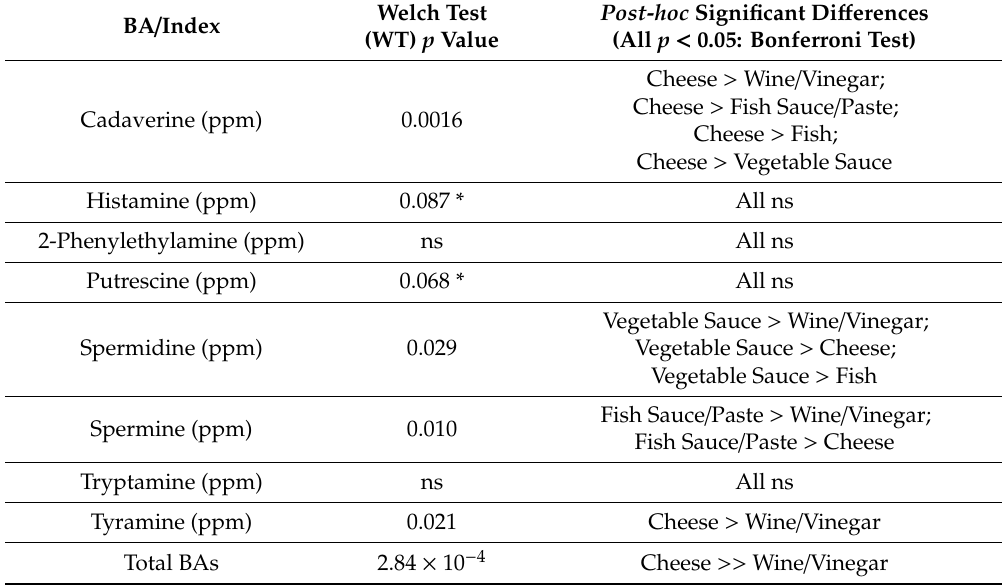
Table 3. Statistical significance and nature of di ff erences between the mean BA contents and other food quality indices for fermented food products. Both robust Welch and Bonferroni-corrected post - hoc ANOVA test significance ( p ) values are provided. Abbreviations: ns, not statistically significant. * These values were close to statistical significance, but did not attain a p value of ≤ 0.05 with the robust Welch